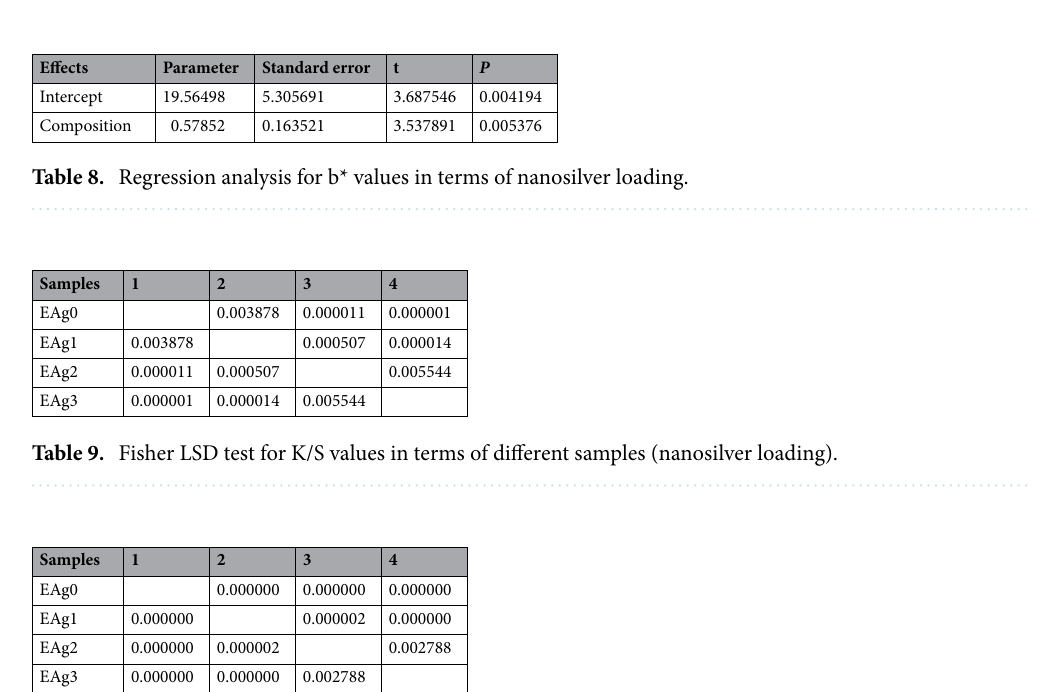
Table 7. Regression analysis for a* values in terms of nanosilver loading.